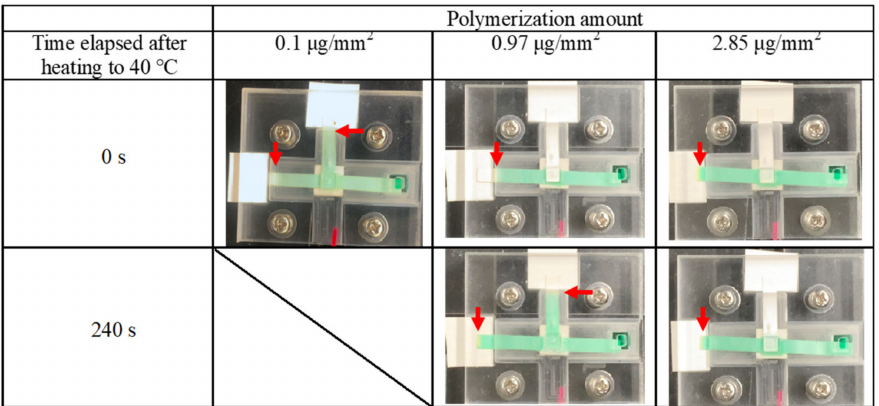
Figure 6. Time-lapse photographs of colored water flowing into the valve function evaluation system, in which each of the membranes with different amounts of polymerization were installed. Colored water was flowed at 25 ◦ C for 240 s before heating of the valve. The valve was heated to 40 ◦ C. Arrows indicate the position of the wetting